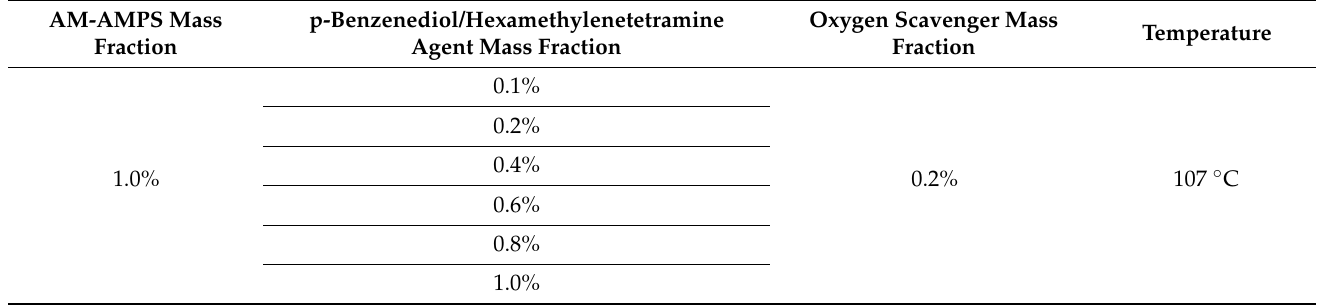
Table 4. Scheme of the crosslinking agent mass fraction optimization experiment.